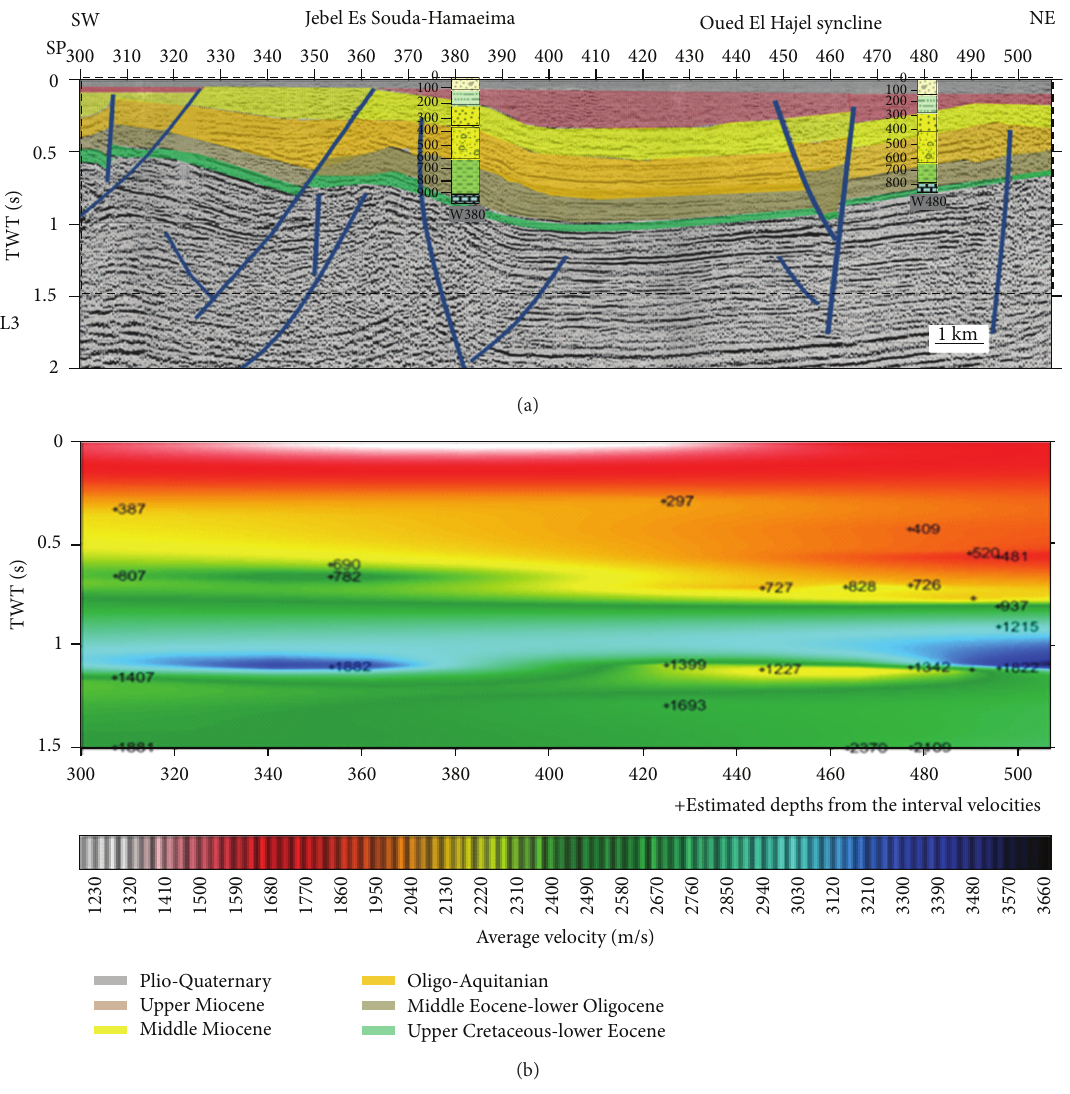
Figure 13: (a) W380 and W480 fictive wells associated with the L3 seismic line and (b) average velocity variation associated with L3 (black dashed line frame). (+) Depths estimated from the